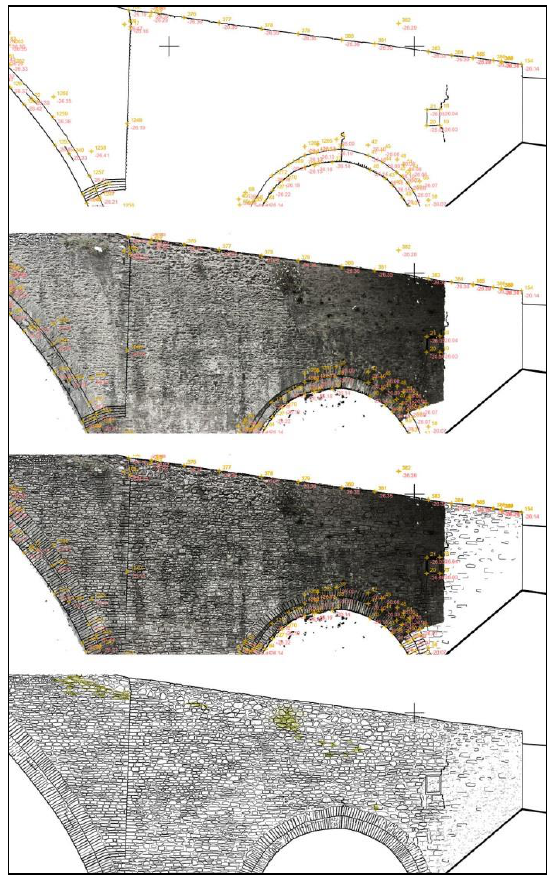
Figure 7. Details of redesign and data gathering process of the South façade before the collapse, by combining orthoimages with the 1984 data. From top to bottom: 1984 plan, 1984 plan / orthoimage, 1984 plan / orthoimage / 2D CAD drawing, 2D CAD drawing.